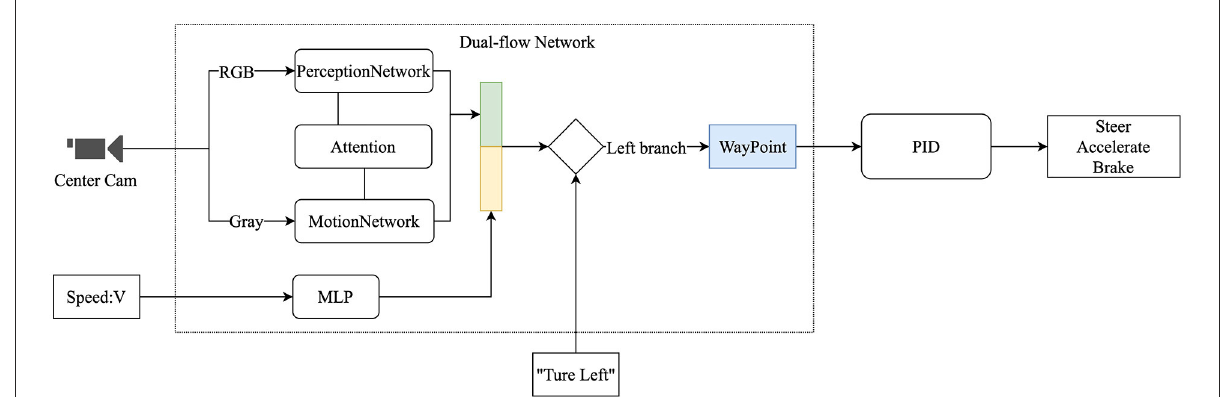
FIGURE2 Flow chart of the overall system. The process has three steps: (1) Using the vehicle’s front camera and speed as inputs, the low-sampling RGB image is used as input to the perception network, and the high-sampling grayscale images are used as input to the motion network; (2) The dual-flow network overlapping the high-level navigation commands performs the prediction of waypoints; and (3) The final output of the vehicle’s low-level control commands is produced through the PID